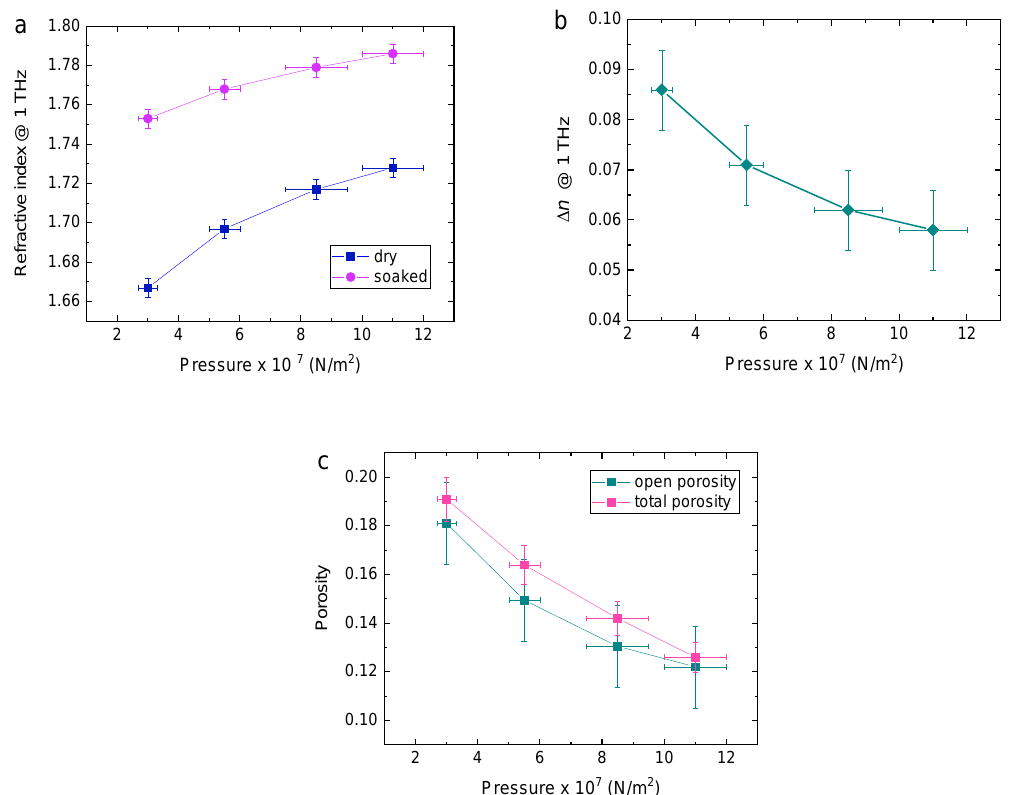
Figure 5. ( a ) Refractive indices of dry and paraffin-soaked pellets @ 1 THz as a function of pressure. The errors in the refractive index are the standard deviation of four pellet samples. ( b ) Refractive index difference @ 1 THz between dry and paraffin-soaked pellets as a function of pressure. ( c ) Total porosity using Equation (2) and open porosity calculated from data in ( b ) and Equation (3), as a function of pressure.